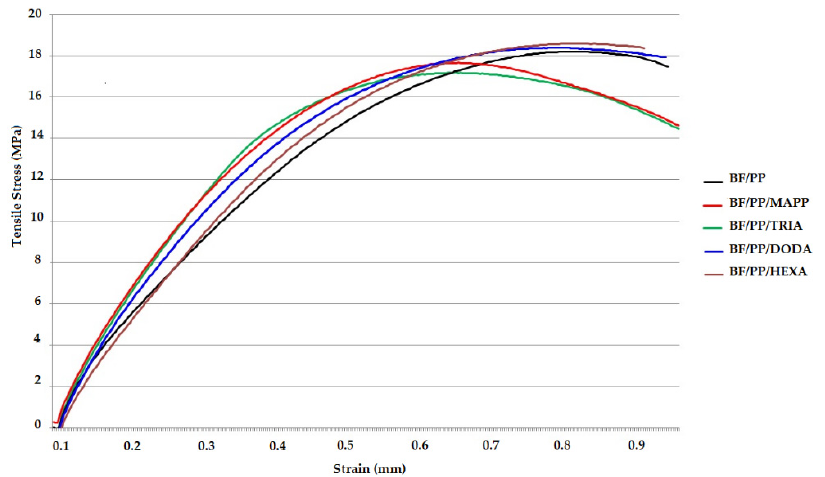
Figure 3. Tensile stress–strain curves of the composites without and with CA.